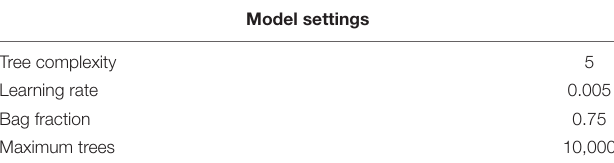
TABLE 1 | Boosted regression trees settings applied to all